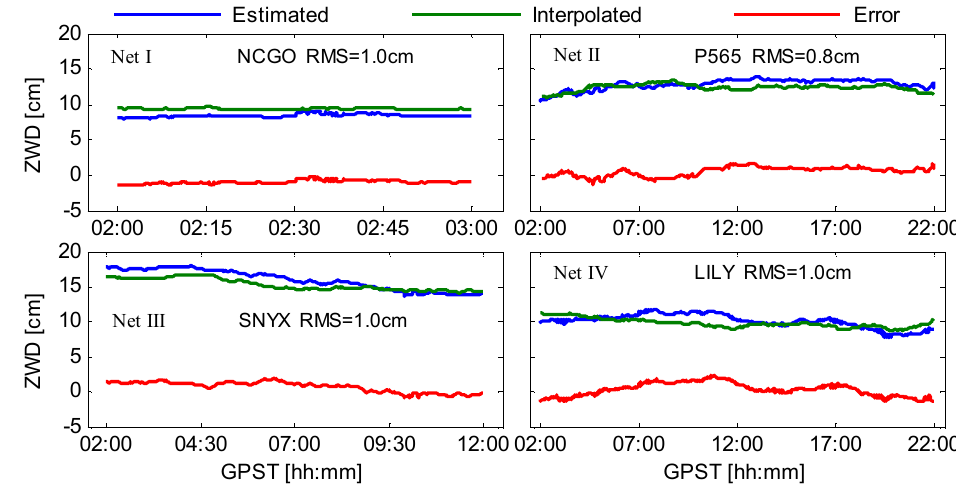
Figure 6. ZWD interpolation results of NCGO, P565, SNYX, and LILY. Figures 7–10 show the BSSD ionosphere errors of these four stations and among them, different colors indicate different satellites. For station NCGO, P565, and SNYX, the interpolation error of each satellite generally did not exceed 5 cm. For the entire period, the interpolation accuracy was 0.9 cm, 0.9 cm, and 1.3 cm, respectively. The interpolation error of LILY was relatively large, even exceeding 15 cm in certain periods. The main rea- son for this phenomenon is that the average inter-distance of network I~III was within the range of about 90 km to 140 km, while the average inter-distance of network IV could reach about 369 km, as can be seen from Table 2. Generally speaking, the spatial correla- tion of atmosphere decreases as the distance between stations increases, thus the interpo- lation accuracy of LILY was relatively lower, and the RMS was only 4.4 cm.